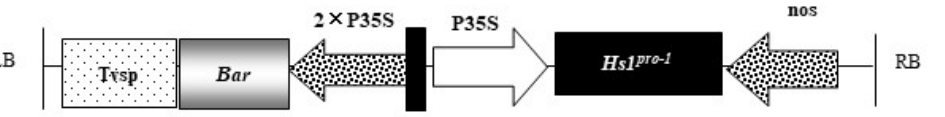
Figure 8. T-DNA region of the expression binary vector p Hs1. The Hs1 pro − 1 and bar genes were driven by a CaMV 35S promoter. The Bar gene conferred glufosinate tolerance for selection of transgenic plants. LB, left border; RB, right border; Tvsp, soybean storage protein terminator; Bar , phosphinothricin acetyltransferase gene; P35S, cauliflower mosaic virus (CaMV) 35S promoter; Hs1 pro − 1 , gene (gene accession number: U79733) ORF; nos, nopaline synthase terminator. Table 5. T-DNA vector elements, location, size, and function in each plasmid vector. T-DNA Vector Elements